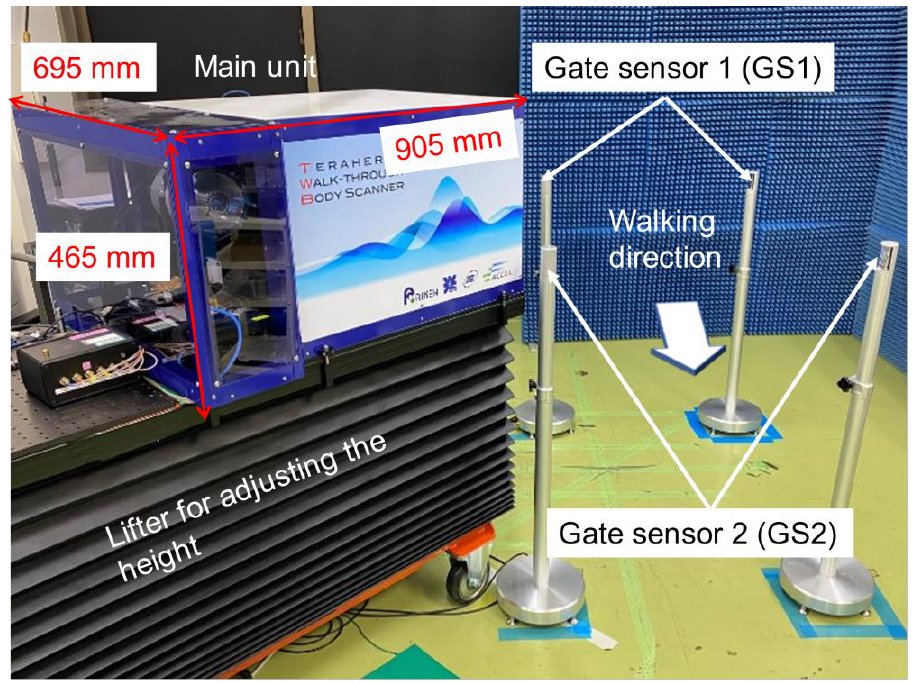
Figure 3. Photograph of our walk-through body